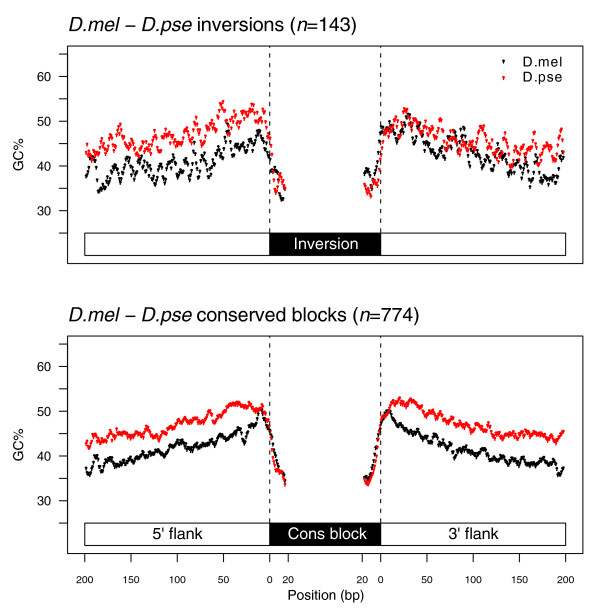
GC content across microinversion breakpoints and conserved sequence blocks. Top panel: 143 Drosophila melanogaster-D. pseudoobscura microinversions. For each microinversion breakpoint we extracted 200 bp flanking the breakpoint and 20 bp internal to the inversion as a contiguous section (we examined just 20 bp internal to each inversion breakpoint as the minimum inversion size was 40 bp). For each species, across all sequences for a given inversion breakpoint, we calculated GC content for all overlapping 5 bp windows. Each point in the plot represents the mean GC content for a single window. Vertical dashed lines indicate the inversion breakpoints. Note that the distance between these lines is variable across inversion events. Bottom panel: 774 Drosophila melanogaster-D. pseudoobscura conserved non-coding blocks. Using sliding-window BLAST data we identified all blocks of conserved non-coding sequence from the 93 genes harboring intronic microinversions (see Materials and methods for details). Sequence data were extracted from in/around the conserved blocks and analyzed as described for the microinversion data.